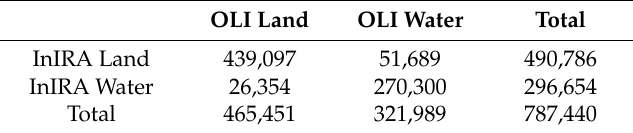
Table 4. Error matrix for the classification results of Image